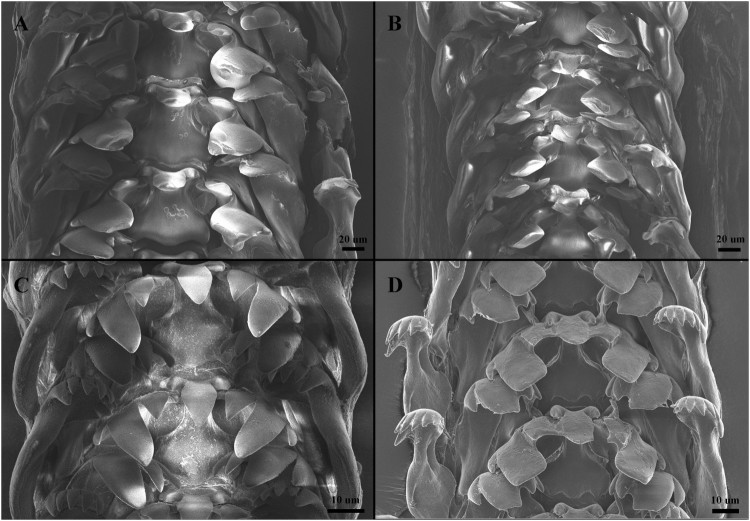
SEM images of radulae for the three Korean Littorina species. A = L. brevicula (Philippi, 1844) from Uido-ri. B = L. brevicula (Philippi, 1844) from Modong-ri. C = L. sitkana Philippi, 1846. D = L. horikawai Matsubayashi & Habe in Habe, 1979.